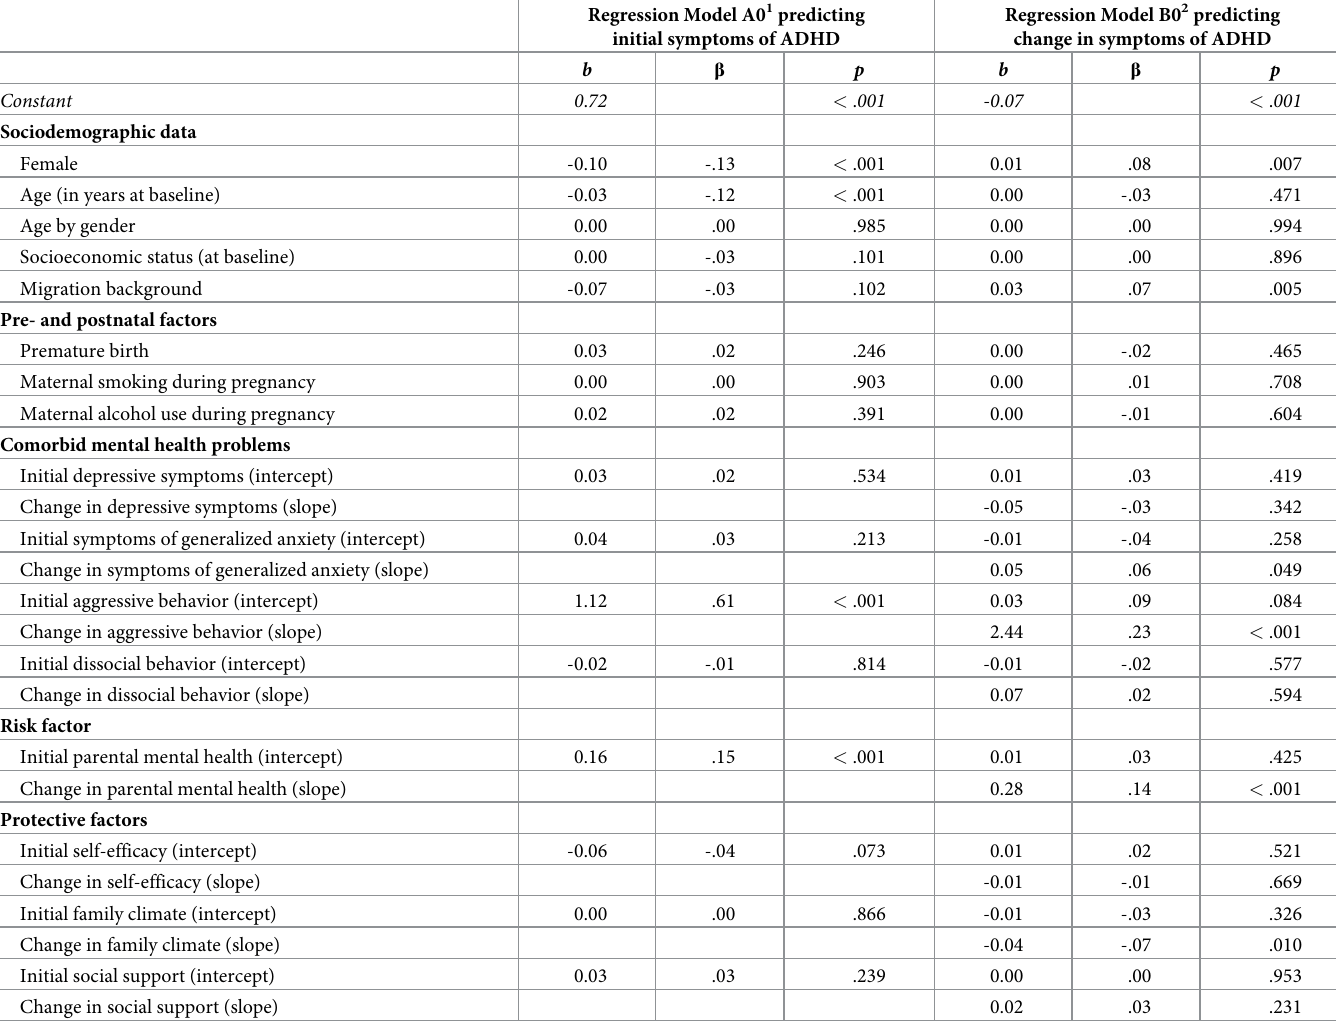
Table 2. Predictors of the initial state and the change of symptoms of attention-deficit/hyperactivity disorder in children and